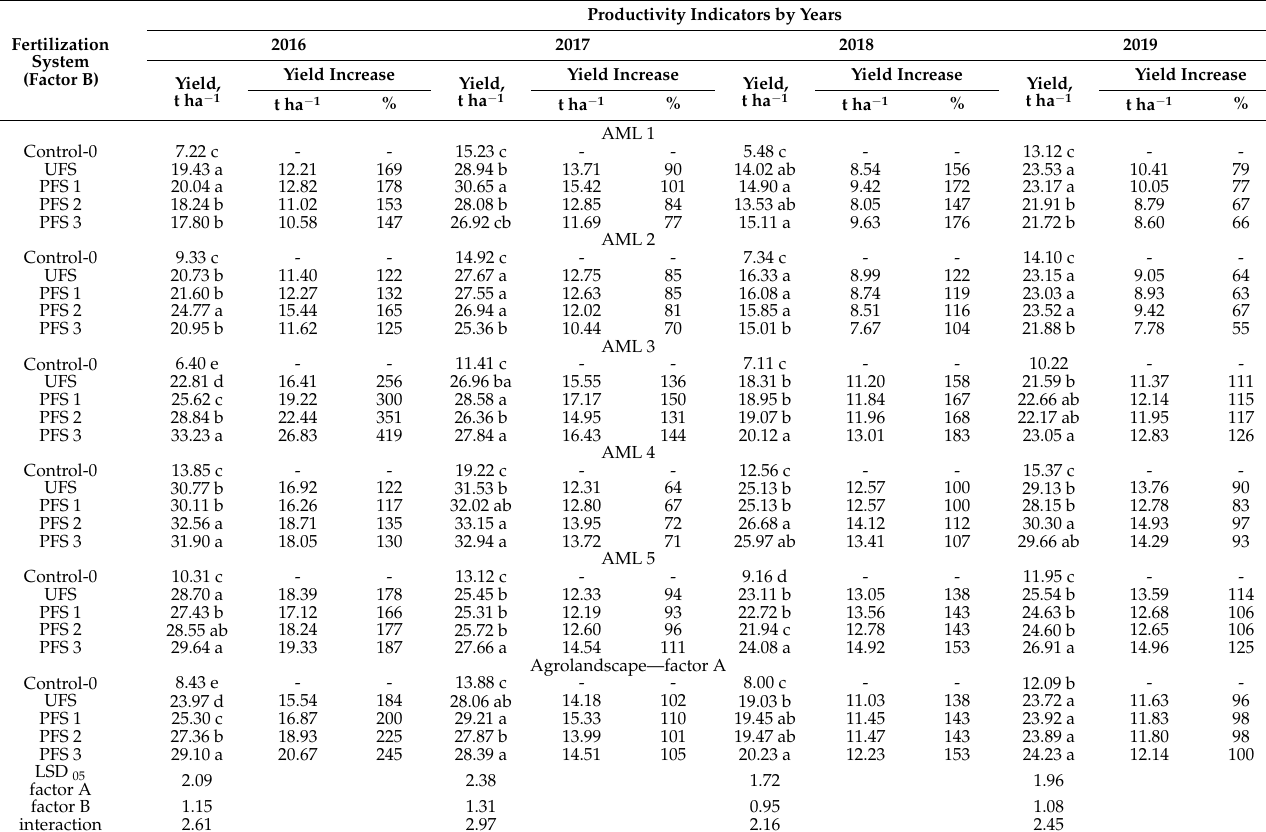
Table 6. Influence of AML conditions and fertilization systems on perennial grass